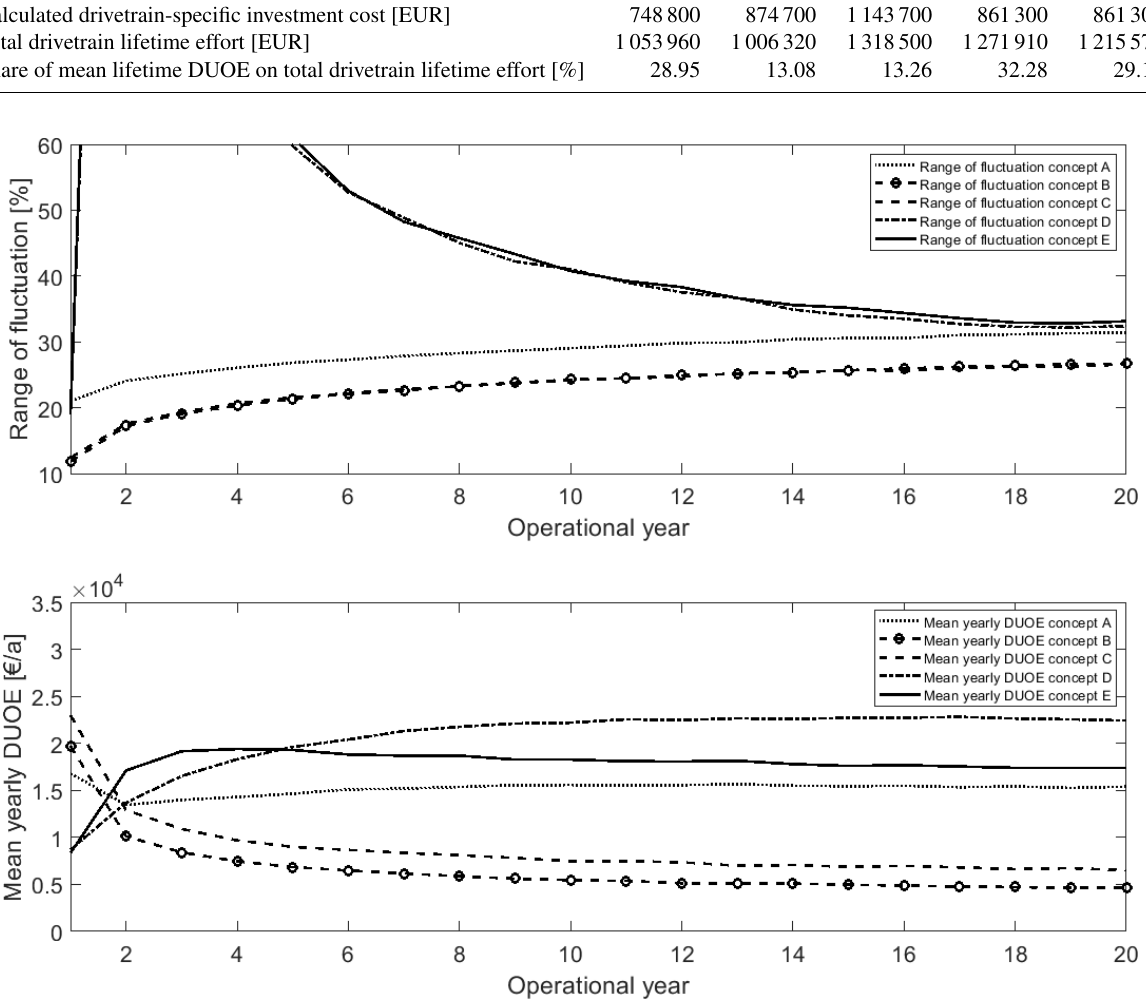
Figure 6. Mean unplanned yearly DUOE and yearly range of fluctuation in DUOE for different drivetrain concepts based on 1000000 iterations for a 3MW, 120m rotor diameter